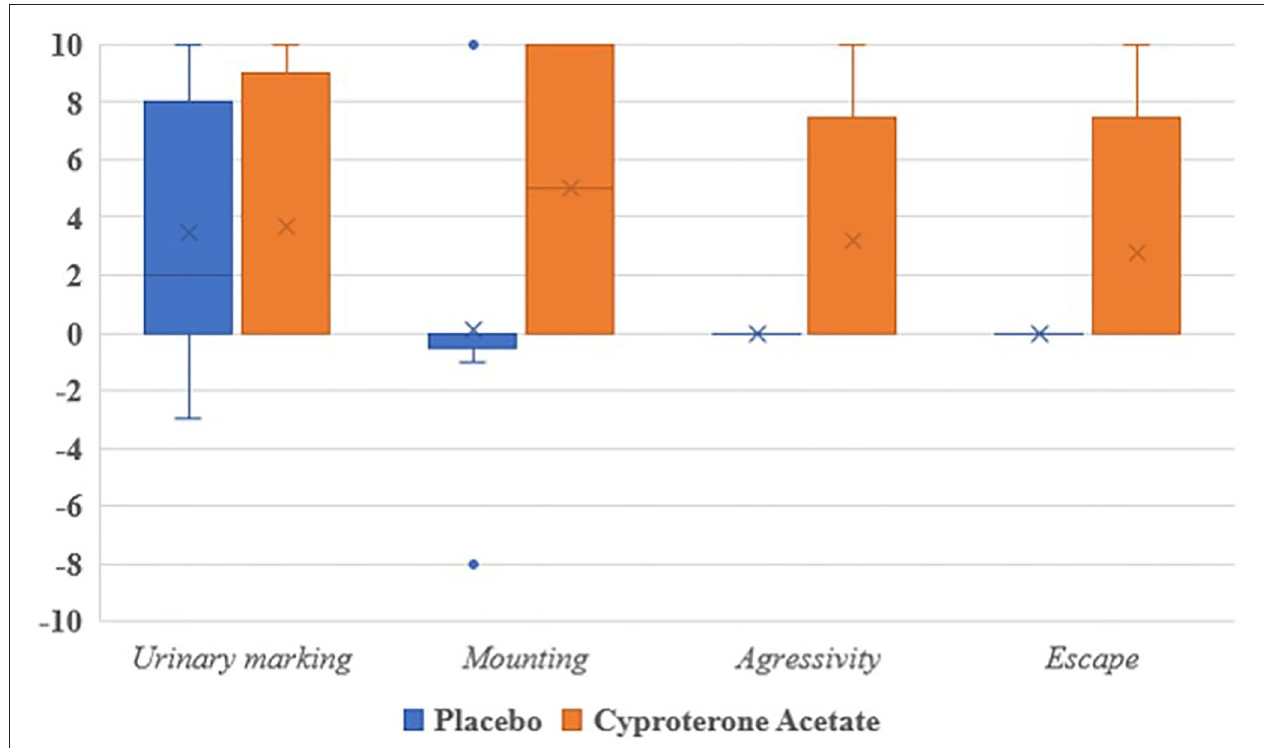
FIGURE 3 | Behavioral scores per symptoms and treatment groups at